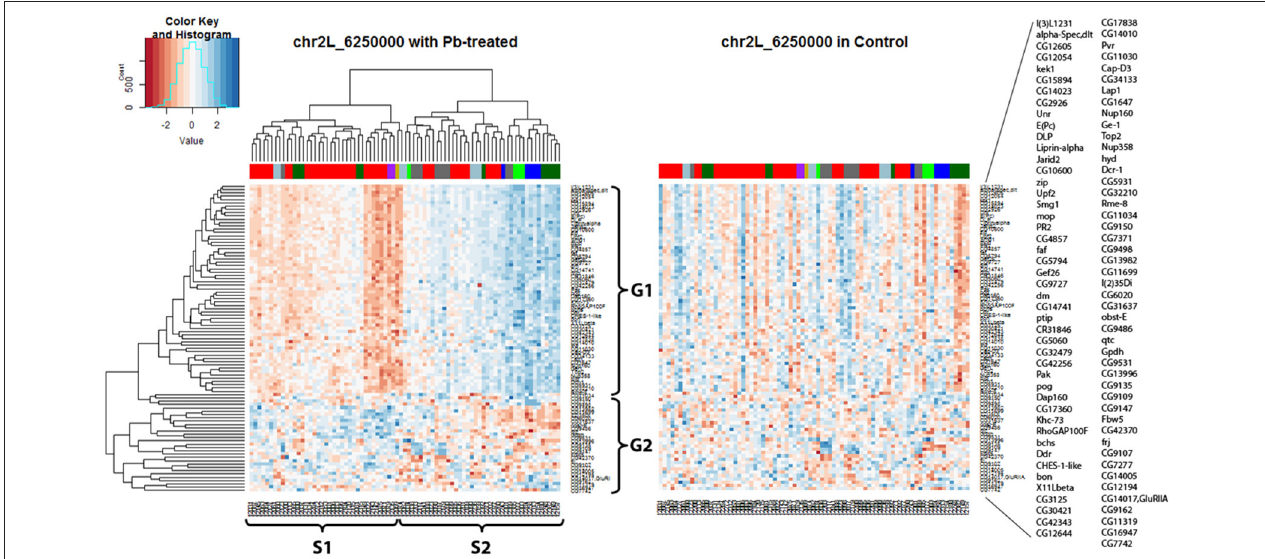
FIGURE 5 | Trans- eQTL hotspot at Chr 2L: 6,250,000 ( p -value < 0.05 at 1,000 permutation threshold). Hierarchical clustering analysis was done according to the expression profiles of the Chr 2L: 6,250,000 associated genes ( p -value < 0.05). On the left heatmap plotted by using the lead-specific trans- eQTL, the bottom list indicates all the sample names and the right list indicates all the associated genes. The right heatmap was created by keeping the order of the sample names and associated gene names in the lead-treated plot on the right but replacing with control expression data. The expression patterns formed in lead-treated data disappeared in control data, suggesting this trans- eQTL hotspot could only be observed in expression levels after lead exposure. Color-coded bar above the heatmap and below the dendrogram indicates the original parent of each sample listed at the bottom for this specific location. Color legend for the color-coded bar: red: A1, green: A2, blue: A3, dark green: A4, light blue: A5, purple: A6, gold: A7, darkgray: A8.